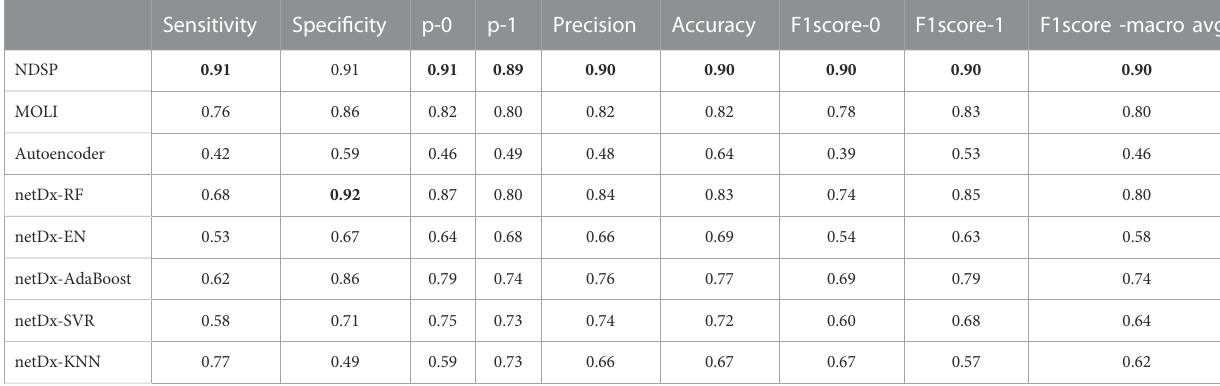
TABLE 1 Index mean of 8 models on targeted therapy drugs.